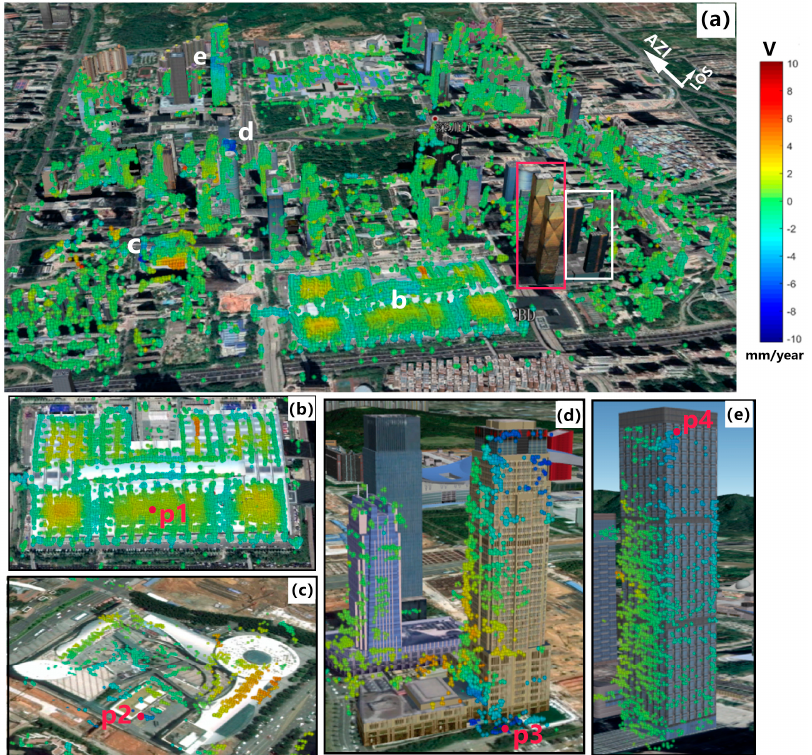
Figure 8. Three-dimensional visualization results of the PS deformation rates. ( a ) The panoramic view of PS deformation rates in study area; ( b – e ) the local magnification of buildings b, c, d, e; the red points p1, p2, p3, and p4 are four deformation feature points on the buildings, and the boxes contain some buildings without PS points.